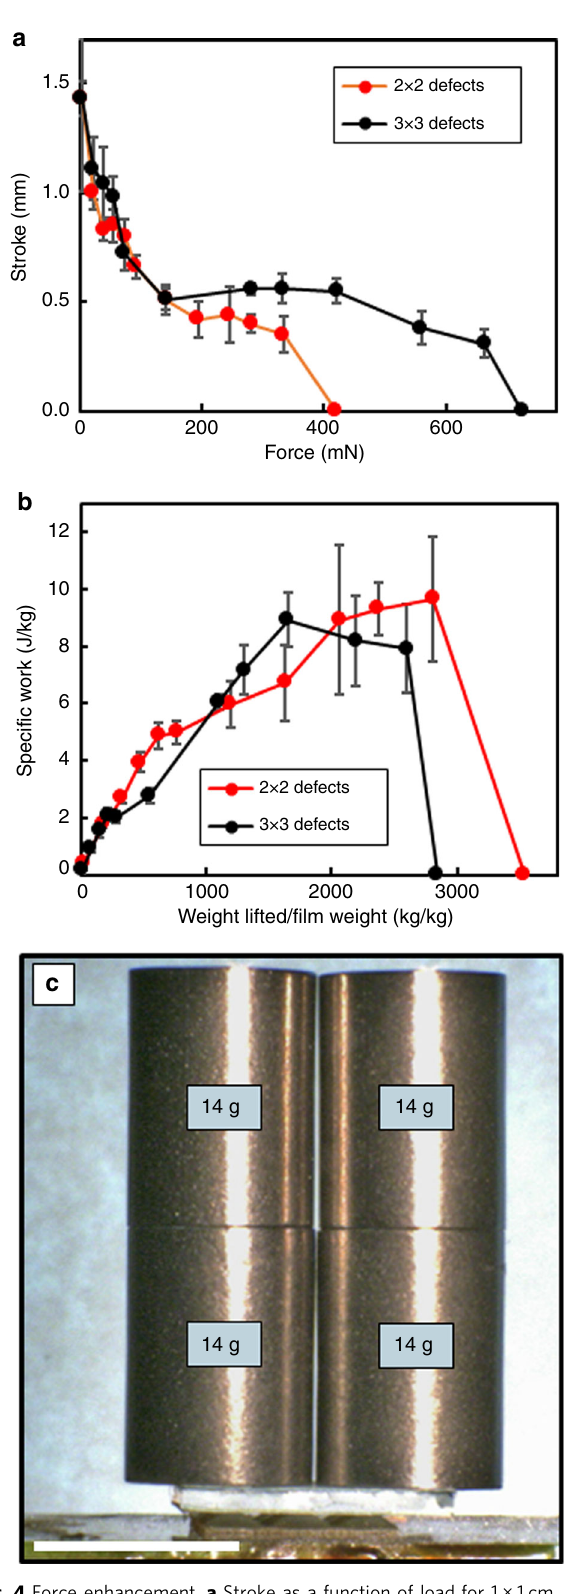
Fig. 4 Force enhancement. a Stroke as a function of load for 1 × 1 cm fi lms patterned with 2 × 2 or 3 × 3 + 1 defect arrays. b Speci fi c work of the 2 × 2 and 3 × 3 arrays. Errors bars represent tilt of the lifted weight and range of three experiments. c Illustration of the deformation of a 1 × 1 cm, four layer LCE laminate (26 mg) lifting over 56 g of load over 0.4 mm. Scale bar is 1 cm